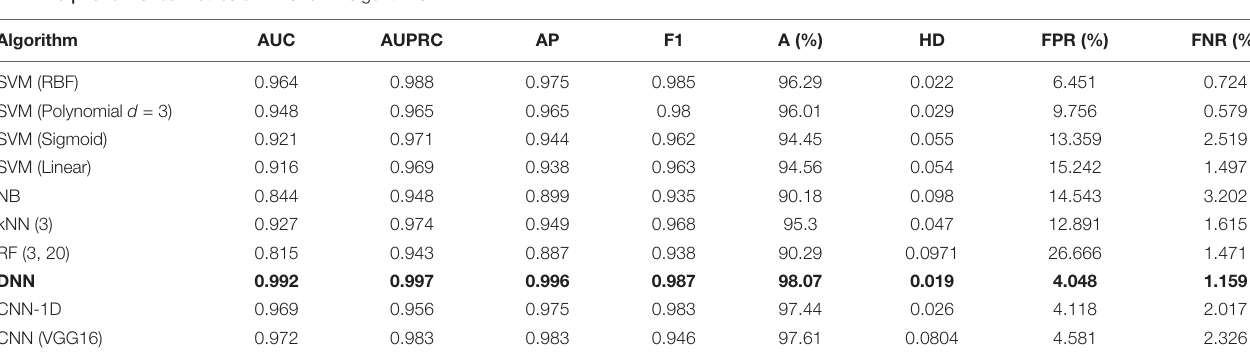
FIGURE 2 | Methodology adopted for predicting the BBB permeability of compounds using SMILES notation. The SMILES notations were used to calculate molecular properties and fingerprints using PaDel. These features were used as input to DNN and CNN-1D to generate the BBB permeability prediction models. The 2D images of compounds were generated using RDkit and fed to the CNN (VGG16) to generate the BBB permeability prediction model. TABLE 6 | Performance metrics of ML and DL